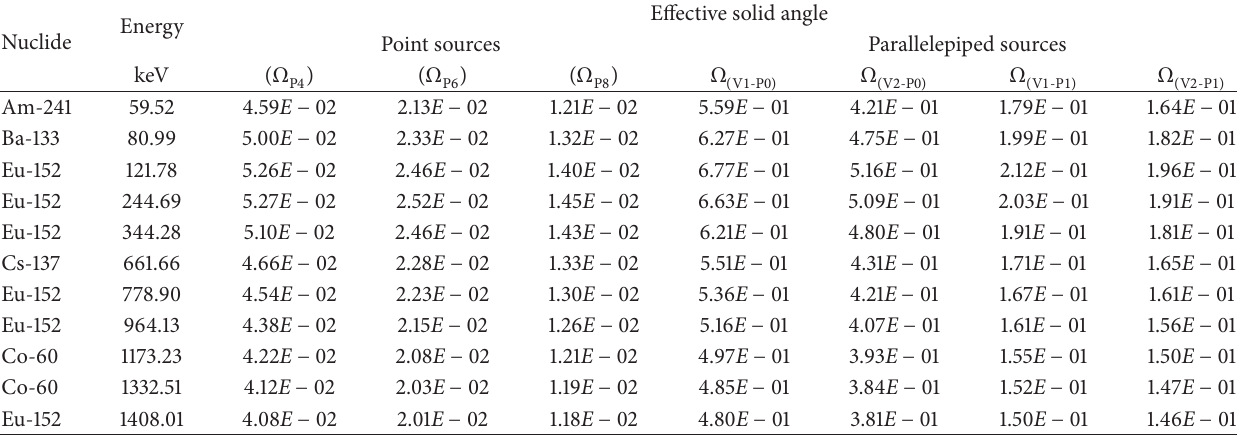
Table 6: Effective solid angle for point and parallelepiped sources at various positions. Energy Nuclide